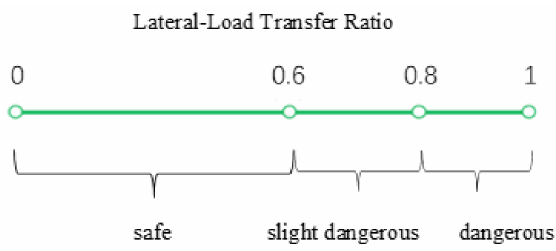
Figure 4. Quantitative diagram of the vehicle rollover risk level.